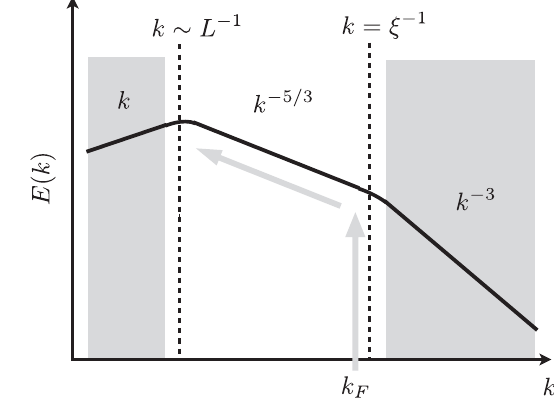
FIG. 6. Illustration of an inertial range (nonshaded region) for the incompressible portion of kinetic energy in forced compress- ible 2DQT. The E ð k Þ / k (cid:2) 3 region arises from the structure of the vortex core and thus is not a signature of vortex configura- tions and vortex turbulence. This ultraviolet region can thus not support energy cascades, nor does this region correspond to (cid:8) (cid:1) (cid:2) 1 in the enstrophy cascades. Net energy injected at k F form of vortices can only move toward the infrared. The Kolmogorov law E ð k Þ / k (cid:2) 5 = 3 occurs in the inertial range of fully developed turbulence. The far-infrared region is given by E ð k Þ / k for a system with no net vorticity, and is evident for k (cid:3) L (cid:2) 1 where L is the largest intervortex distance. For forcing at smaller wave numbers, the spectrum may be more complex, possibly involving other forms of energy and enstrophy